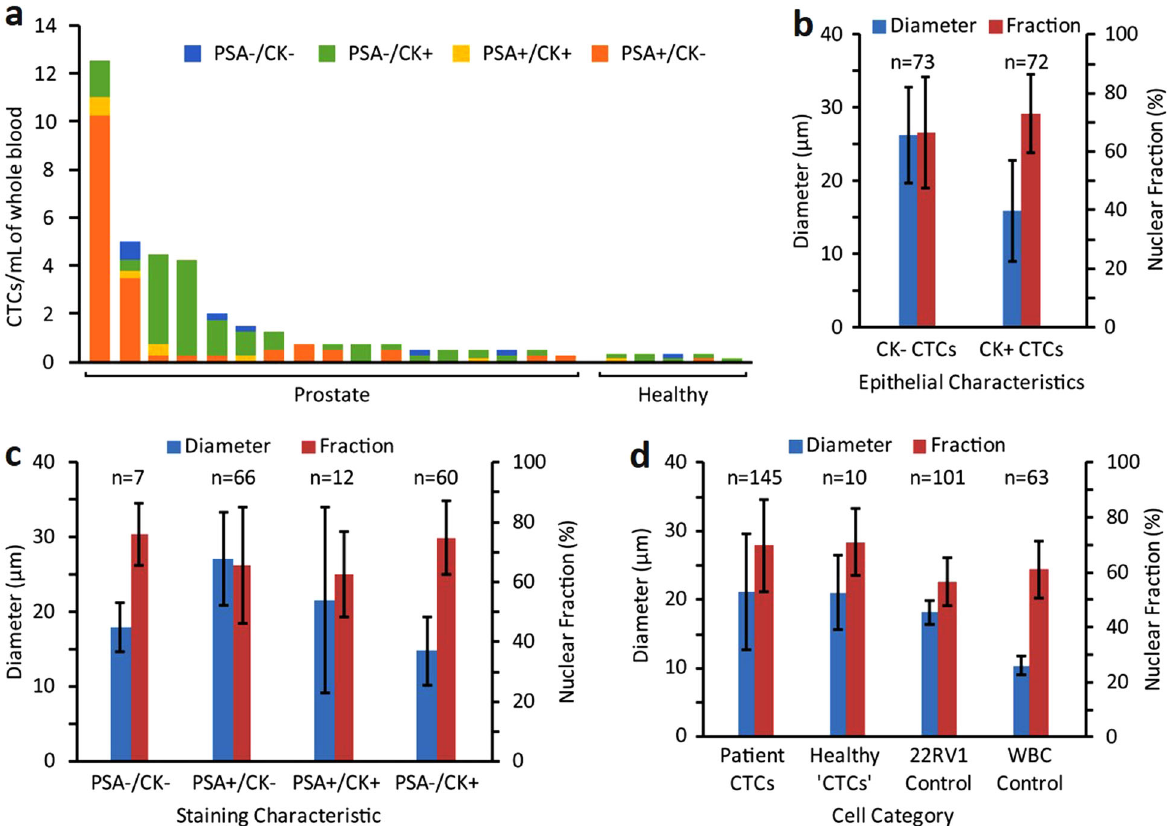
Fig. 4 Characterization of CTC heterogeneity: expression pattern and cell morphology. a Collected CTCs are heterogeneous and display different combinations of PSA and CK within each patient sample. Cells classi fi ed as CTCs in healthy patient samples also exhibit all combinations of PSA and CK markers. b CK+ CTCs (mean 15.9 ± 6.9 µm) were signi fi cantly smaller in diameter than CK − CTCs (mean 26.2 ± 6.5 µm), which suggests potential morphological changes in cells undergoing EMT. c CTCs displayed all combinations of PSA and CK expression with varying size and nuclear fraction. The majority of CTCs were either PSA+/CK − ( n = 66) or PSA − /CK+ ( n = 60). d CTCs isolated from patients had similar sizes and morphologies as the few similarly classi fi ed cells found from healthy donors. CTCs displayed a wide range of sizes (mean 21.1 ± 8.4 µm), and the average diameter and nuclear fraction of CTCs were greater than those of 22RV1 PC and WBC control